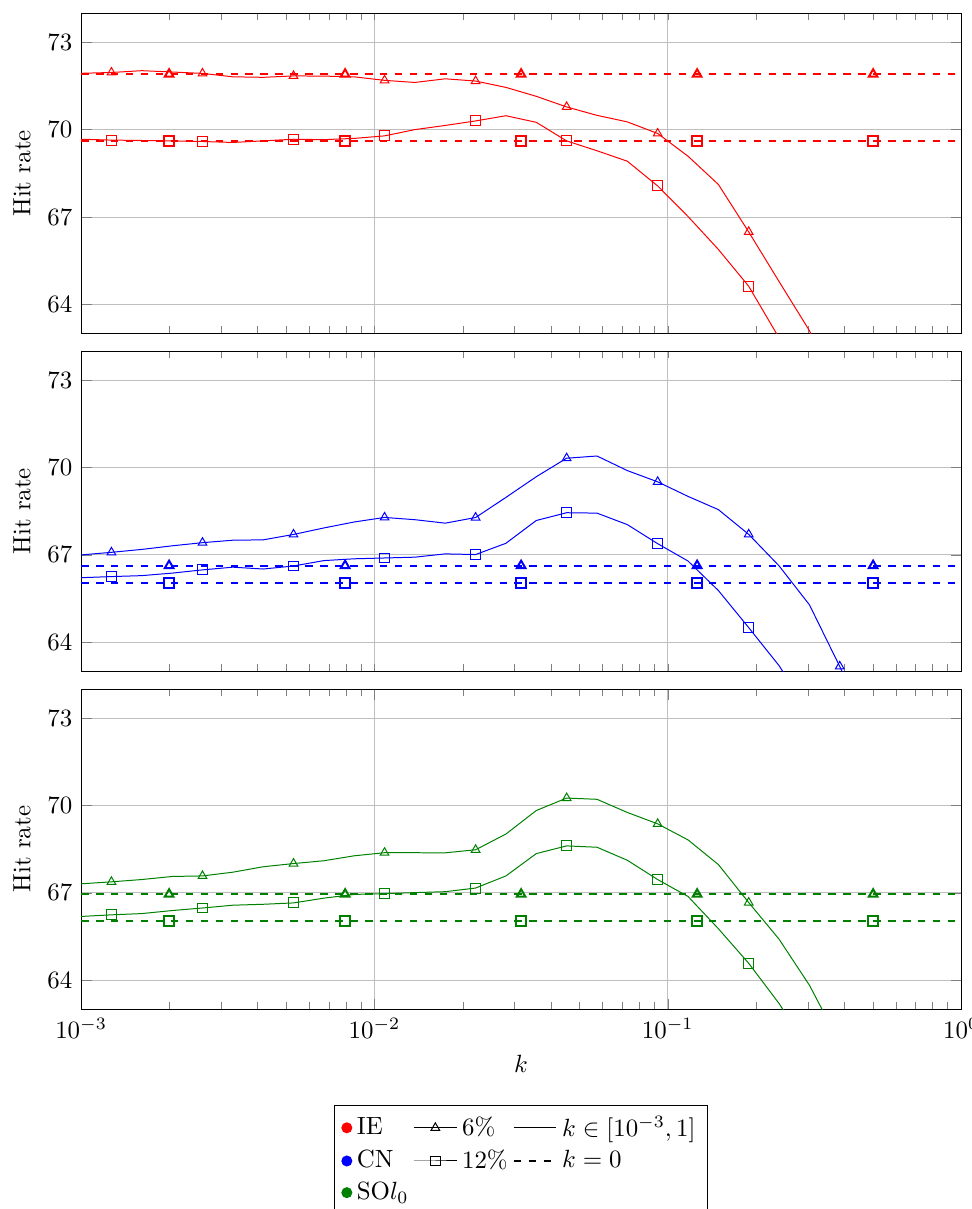
Figure 16. We solved the damped wave equation using different numerical schemes and the δ -peaked initial condition over different k . Then, we computed the hit rate at a geodesic error of 0.25 and plotted the hit rate over different damping parameters k . From ( Top ) to ( Bottom ), we see the hit rate produced with the IE method (red), the CN scheme (blue) and the SO l 0 method (green). With the dashed line, we indicate the results from the k = 0 scenario. The triangle and square denote a noise of 6% and a noise of 12%,